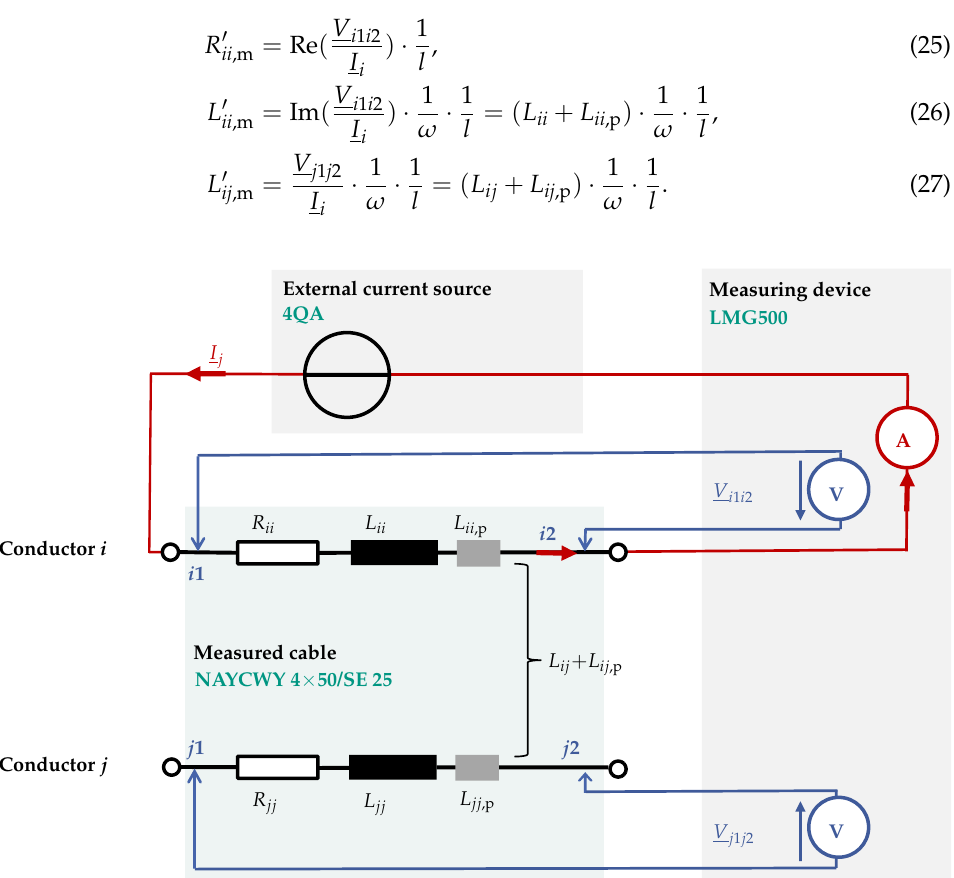
Figure 12. Test setup for measuring resistances and